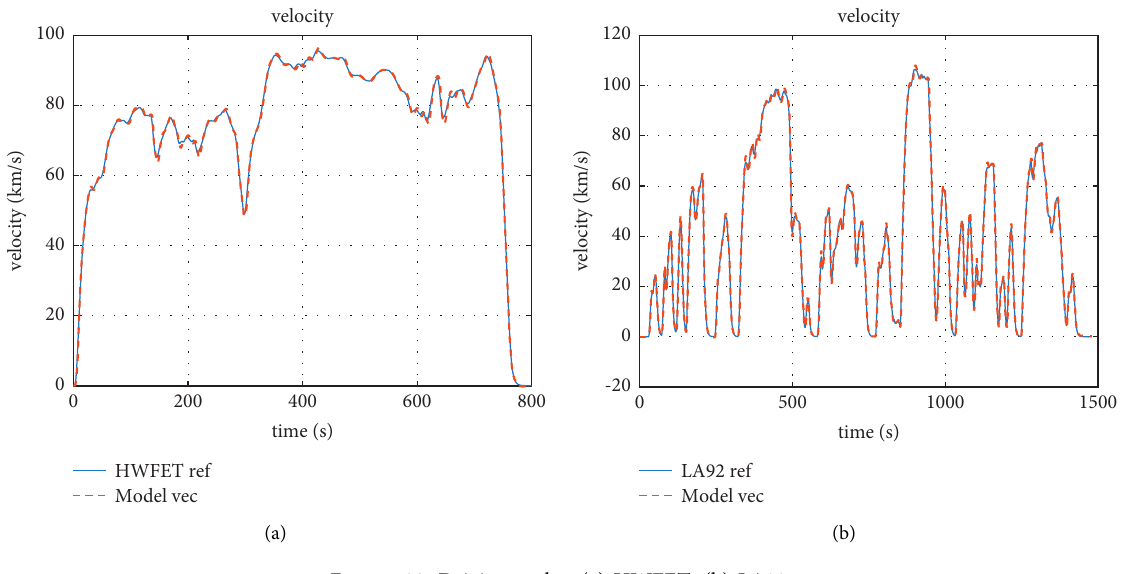
Figure 20: Driving cycles. (a) HWFET. (b)